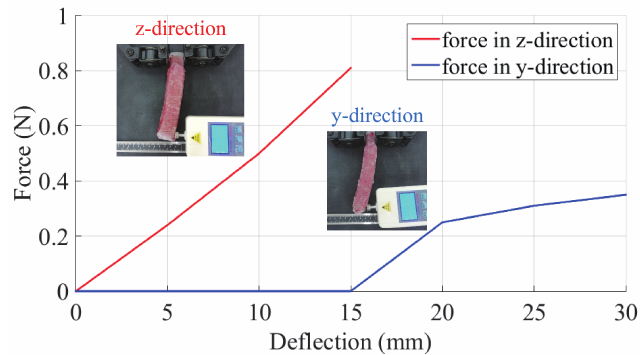
Figure 7. Anisotropic stiffness plotted in the z- and y-directions.